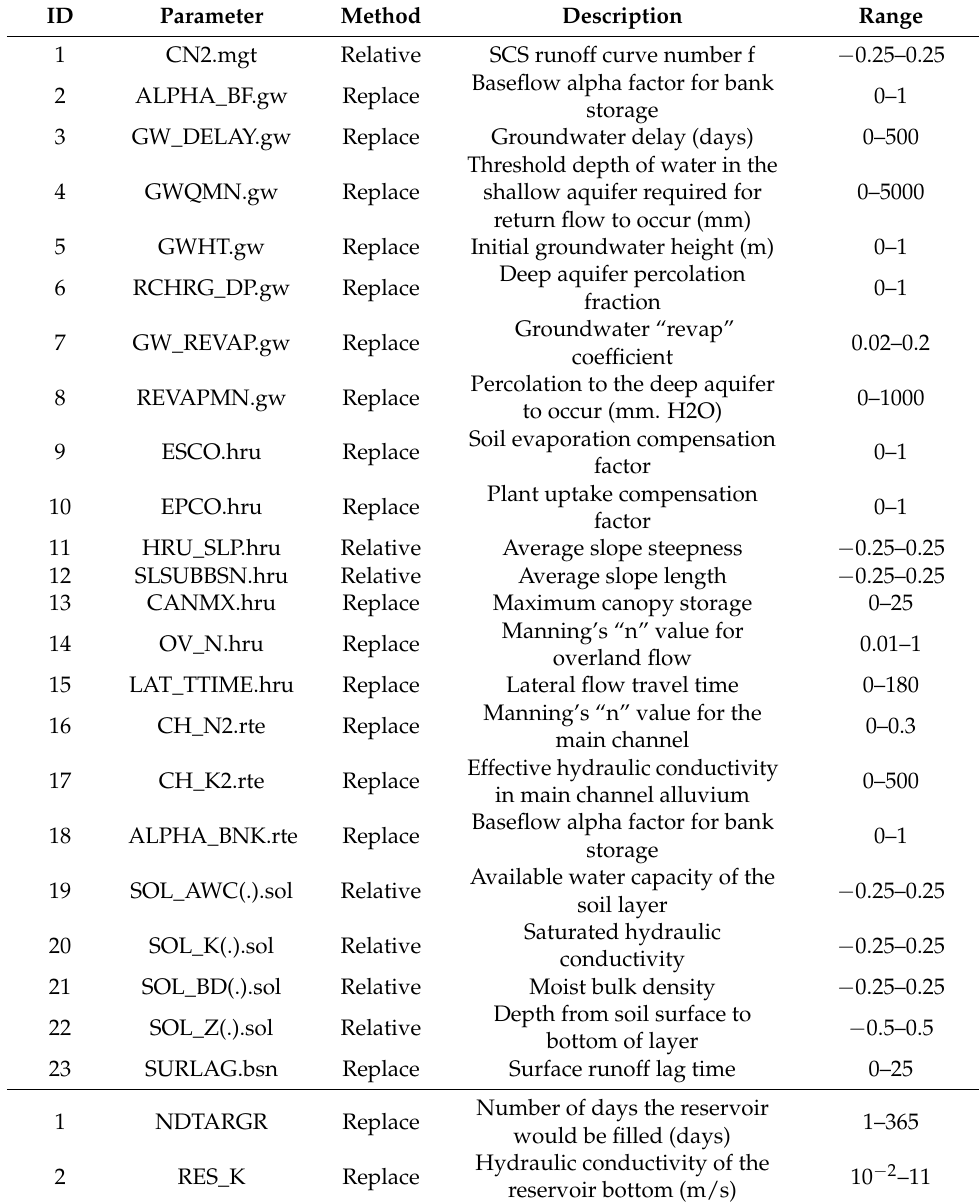
Table 2. SWAT and reservoir parameters for calibration in this